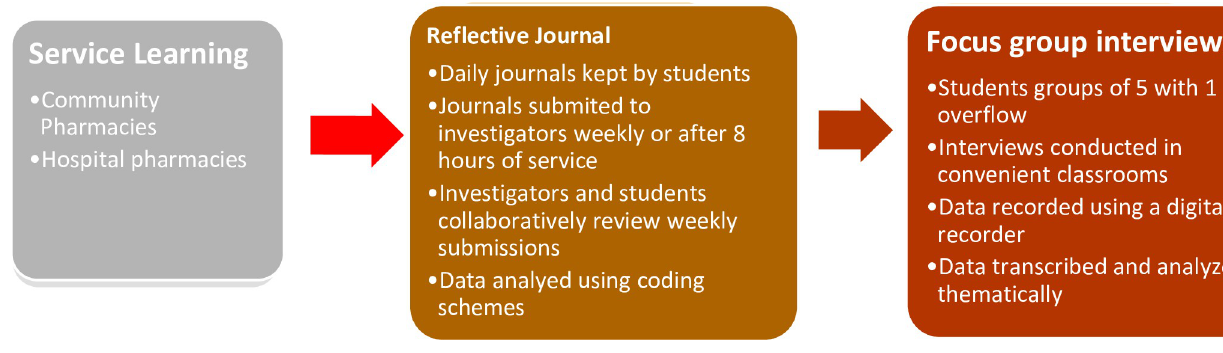
Fig 2. Approach for data collection and